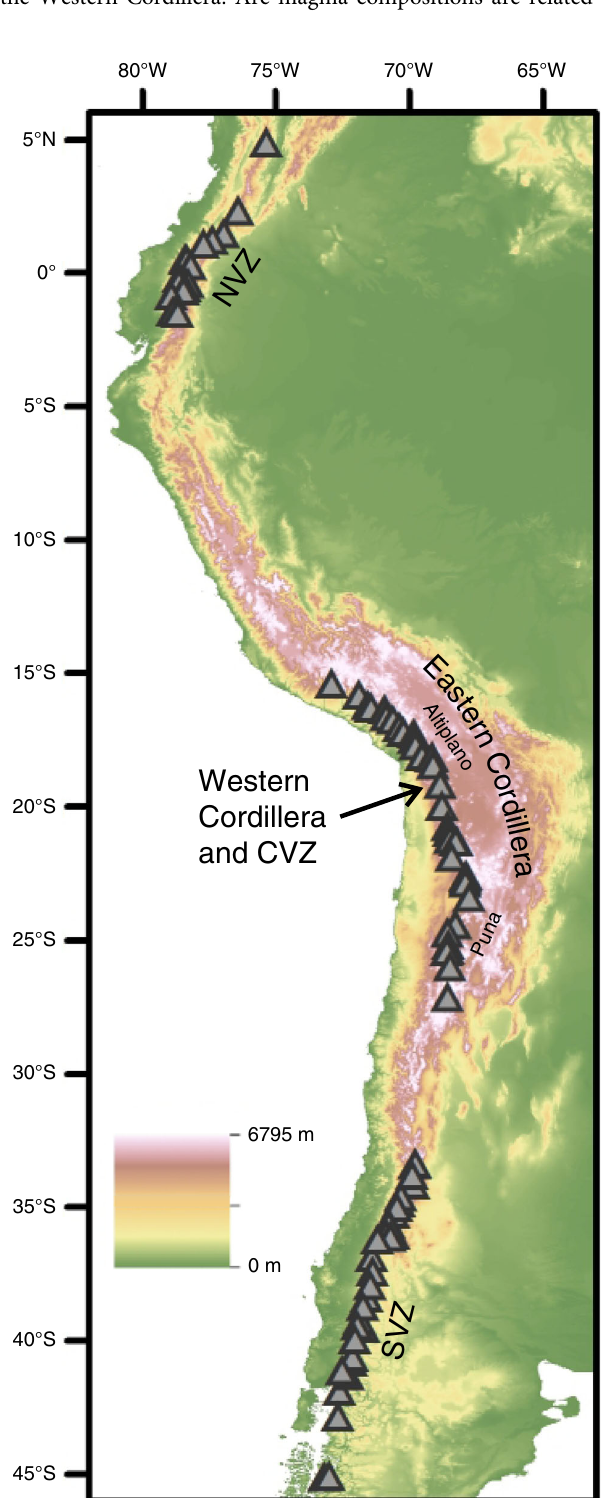
Fig. 1 Topographic map of western South America. Grey triangles are locations of Quaternary arc front volcanoes from the NVZ, CVZ and SVZ (North, Central and Southern Volcanic Zones) included in our geochemical compilation (Methods). CVZ centres are located within the Western Cordillera of the Andean